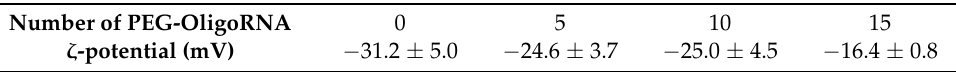
Figure 2. DLS measurement of n *PEG-mRNA at 25 °C. Solid and dotted line represent n *PEG-mRNA samples and PEG-OligoRNA mixture, respectively. Table 1. ζ -potential measurement of n *PEG-mRNA at 25 ◦ C. Data are shown as average mean ± SEM ( n =